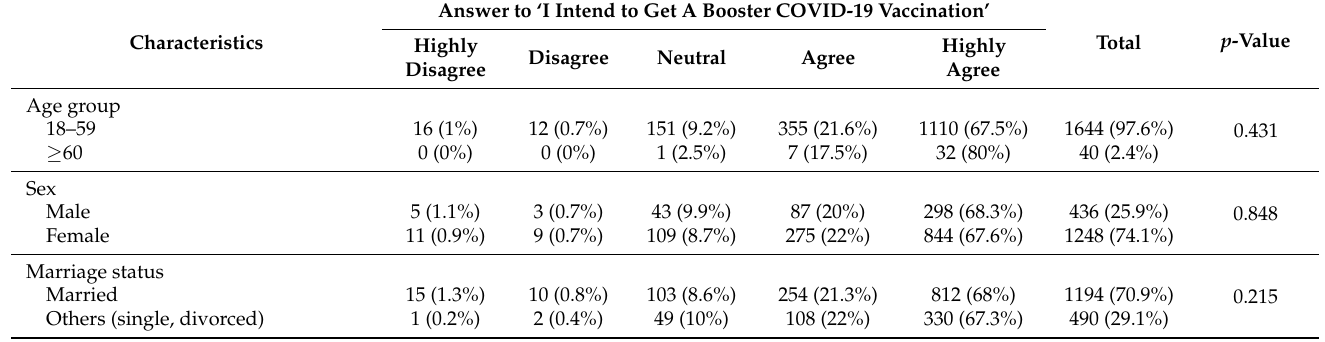
Table 1. Number and percent distribution of participants’ levels of agreement to the statement reflecting intentions for booster shots, Jakarta,